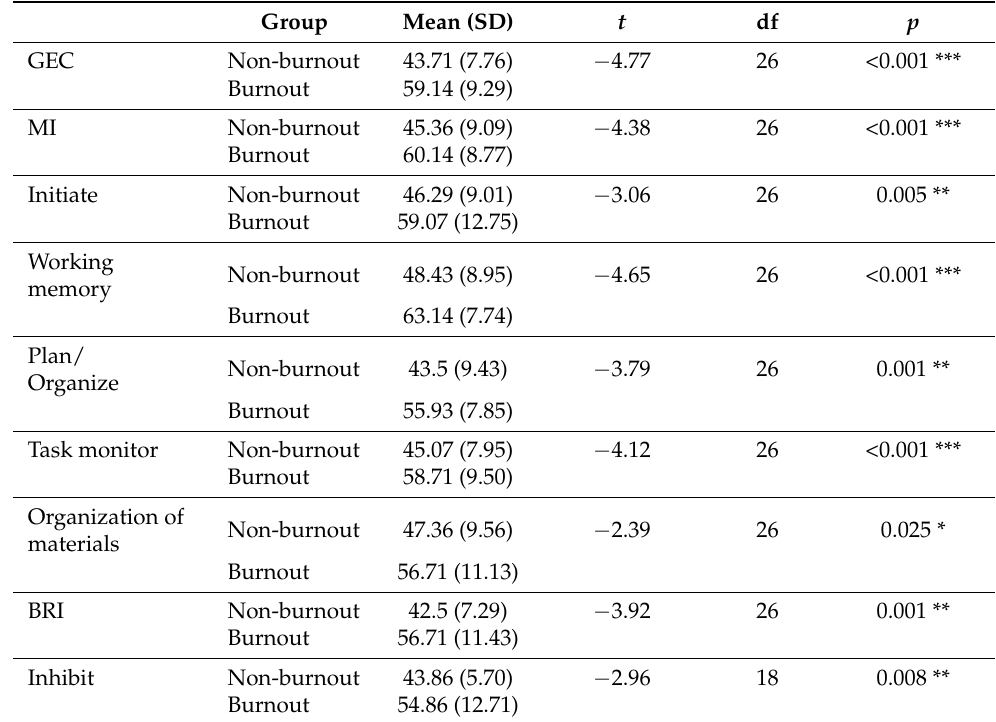
Table 1. BRIEF-A mean scores for the composite score (GEC), the two indices (MI and BRI), and the nine individual clinical EF scales, with standard deviations and t -test results listed for the two groups (non-burnout and burnout) ( p < 0.05 (*), p < 0.01 (**), and p < 0.001 (***)).